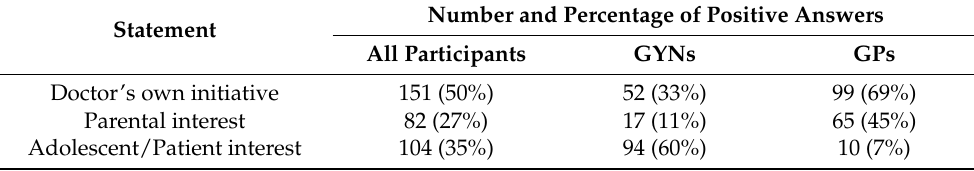
Table 3. Reasons for providing HPV information.